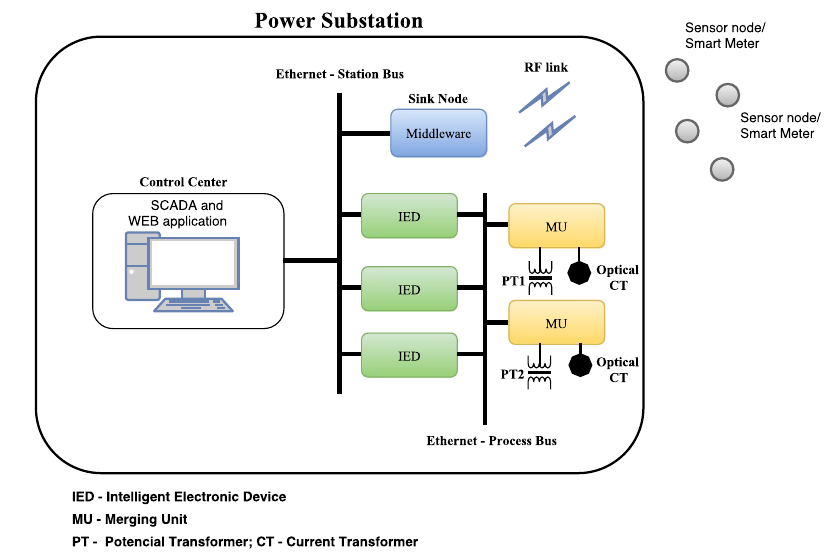
Figure 1. Power substation and proposed